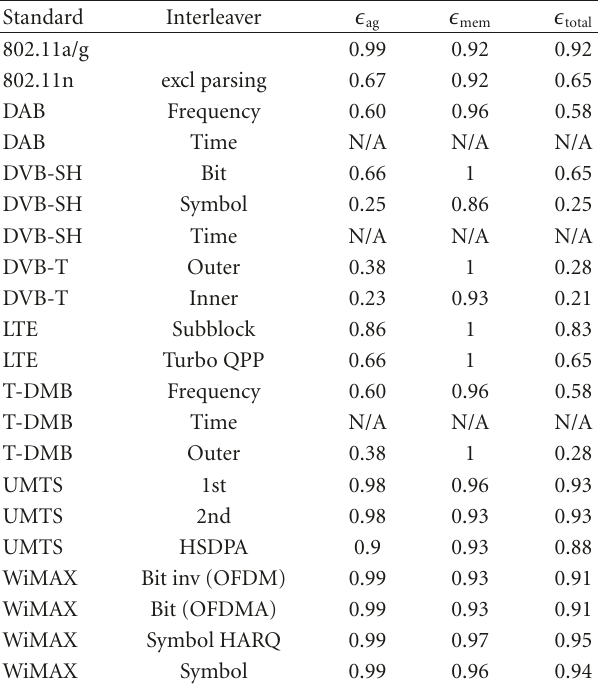
Table 9: Interleaver e ffi ciency